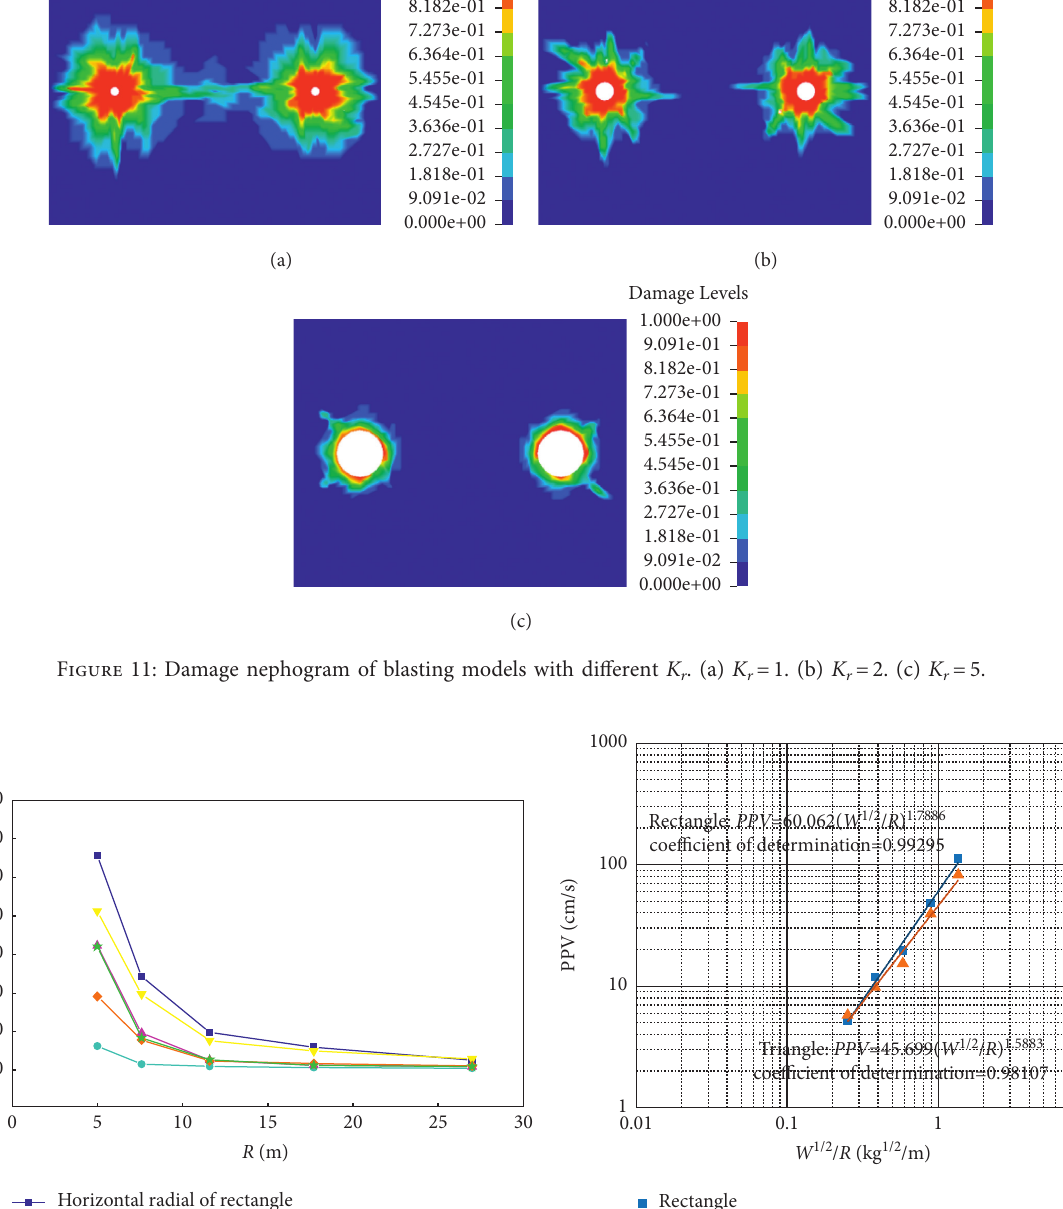
Figure 12: Blasting vibration with different hole arrangements. (a) PPV . (b) Vibration attenuation